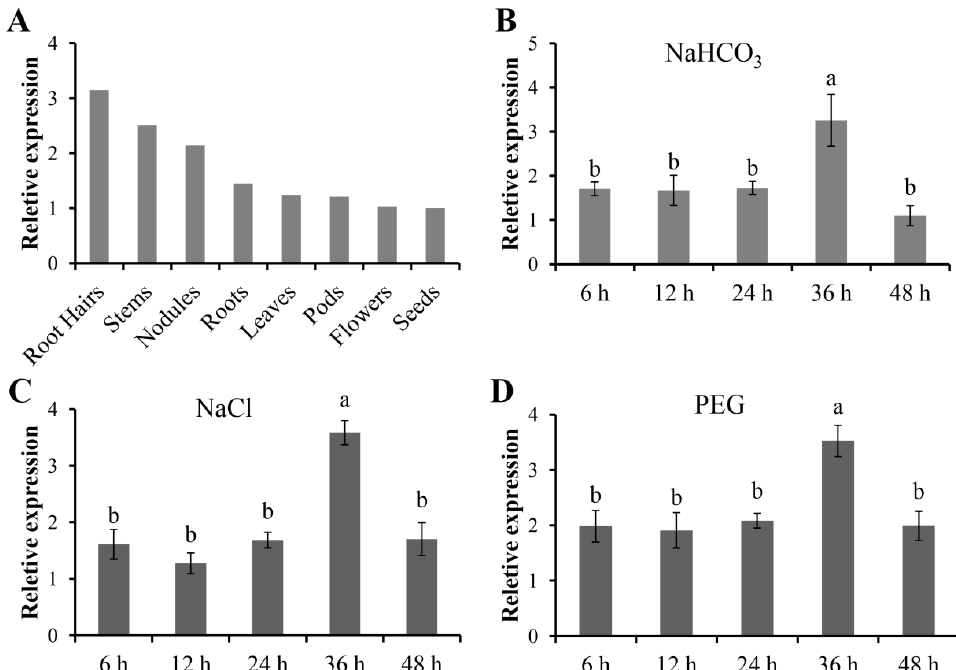
Figure 3. The expression pattern of GmDNAJC7 . ( A ) GmDNAJC7 expression in various tissues of soybean ( Glycine max ) variety Williams 82, using data downloaded from Phytozome (https://phytozome-next.jgi.doe.gov/, accessed on 27 April 2022). The relative expression of GmDNAJC7 was calculated using its expression level in seeds as the control. ( B – D ) Relative expression of GmDNAJC7 in response to alkali, salt, and drought stresses. Fourteen-day-old Tianlong1 soybean seedlings were subjected to NaHCO 3 (90 mM), NaCl (200 mM), or PEG (20%) treatments for 6, 12, 24, 36 or 48 h. The roots of the soybean seedlings were sampled separately, and the relative expression levels of GmDNAJC7 were determined by qRT-PCR, and compared with the samples of the 0 mM treatment at each time point as the control. GmActin11 was used as the reference gene. Data represent the mean ± standard deviation of three biological replications with three repeats within each replication ( n = 3 × 3 = 9). Data with the same letters in lowercases (a, b, and c) above bars indicate no significant differences at the 0.05 level according to the Duncan’s multiple range test.